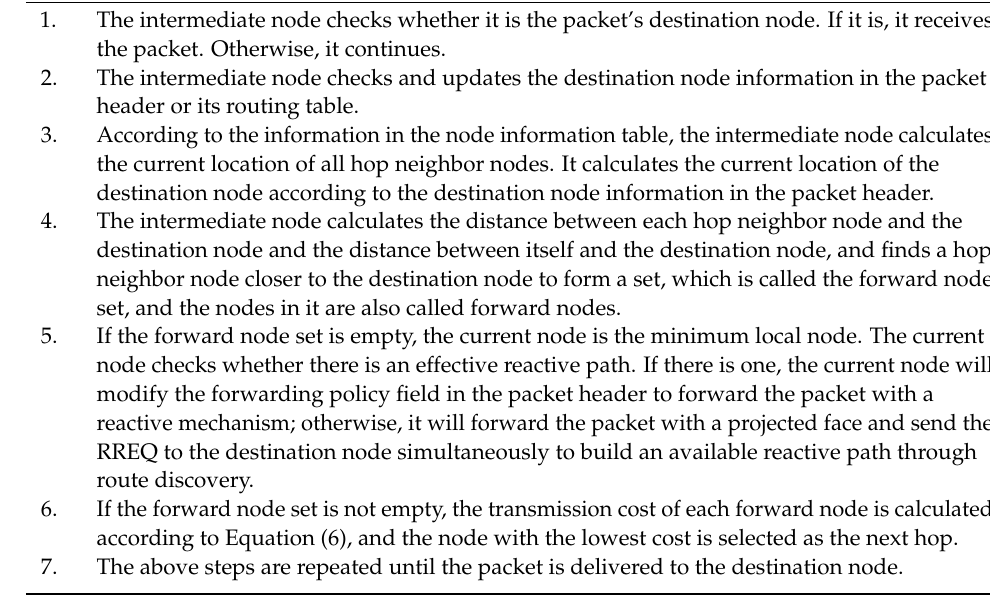
Algorithm 3: RGF protocol greedy forwarding packet